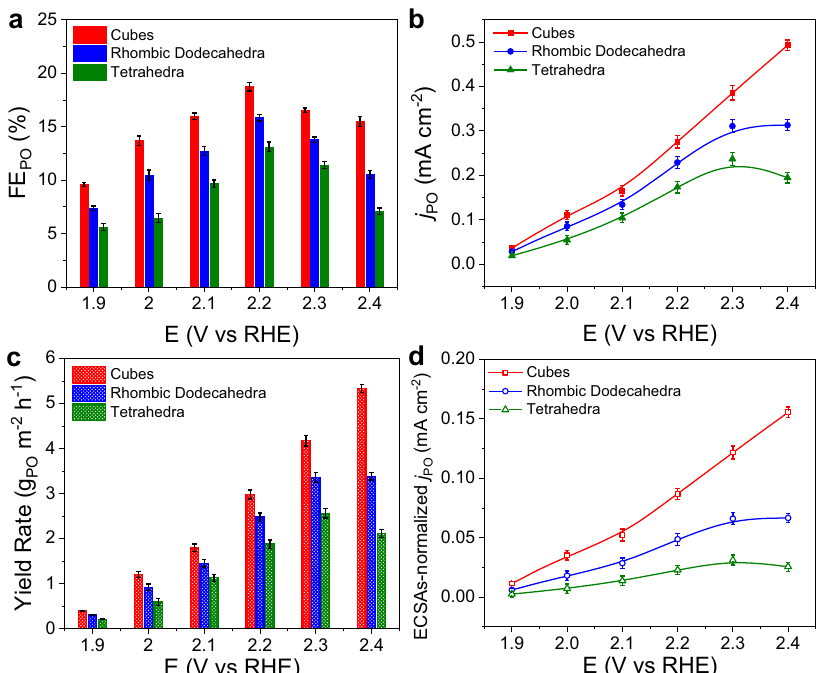
Fig. 2 Catalytic performance of Ag 3 PO 4 crystals for the electrooxidation of propylene. a – d FE PO ( a ), j PO ( b ), yield rates of PO ( c ), and ECSAs-normalized j PO ( d ) over Ag 3 PO 4 crystals. The error bars represent the standard deviations for the three independent